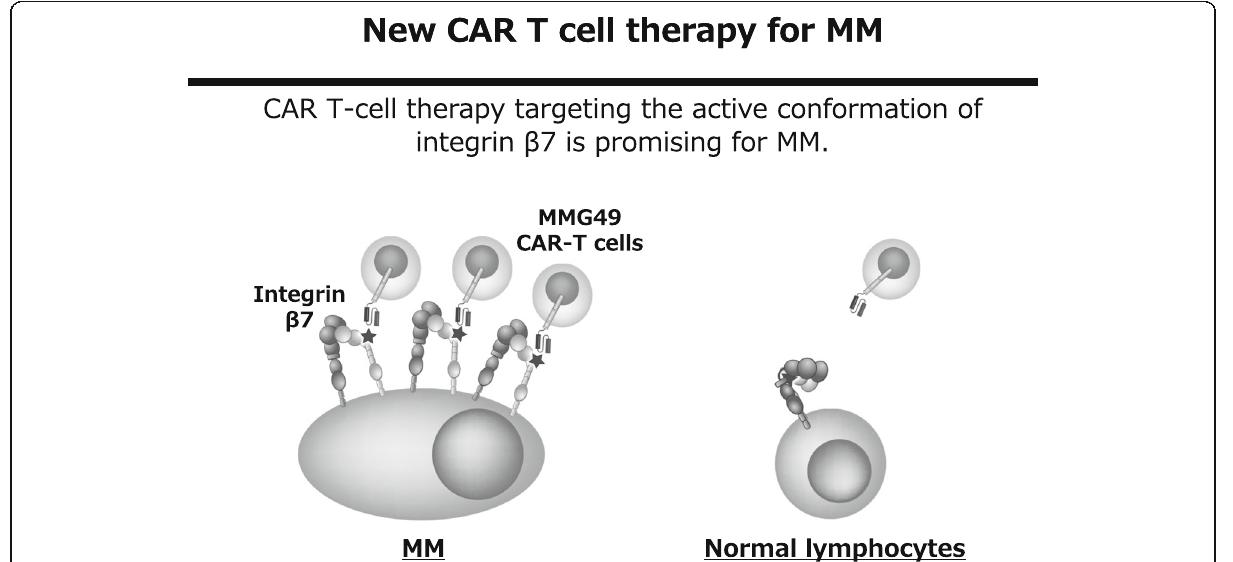
Fig. 3 MMG49 CAR T cell provides the first clear evidence that a receptor protein with a rare but physiologically relevant conformation could serve as a target for cancer